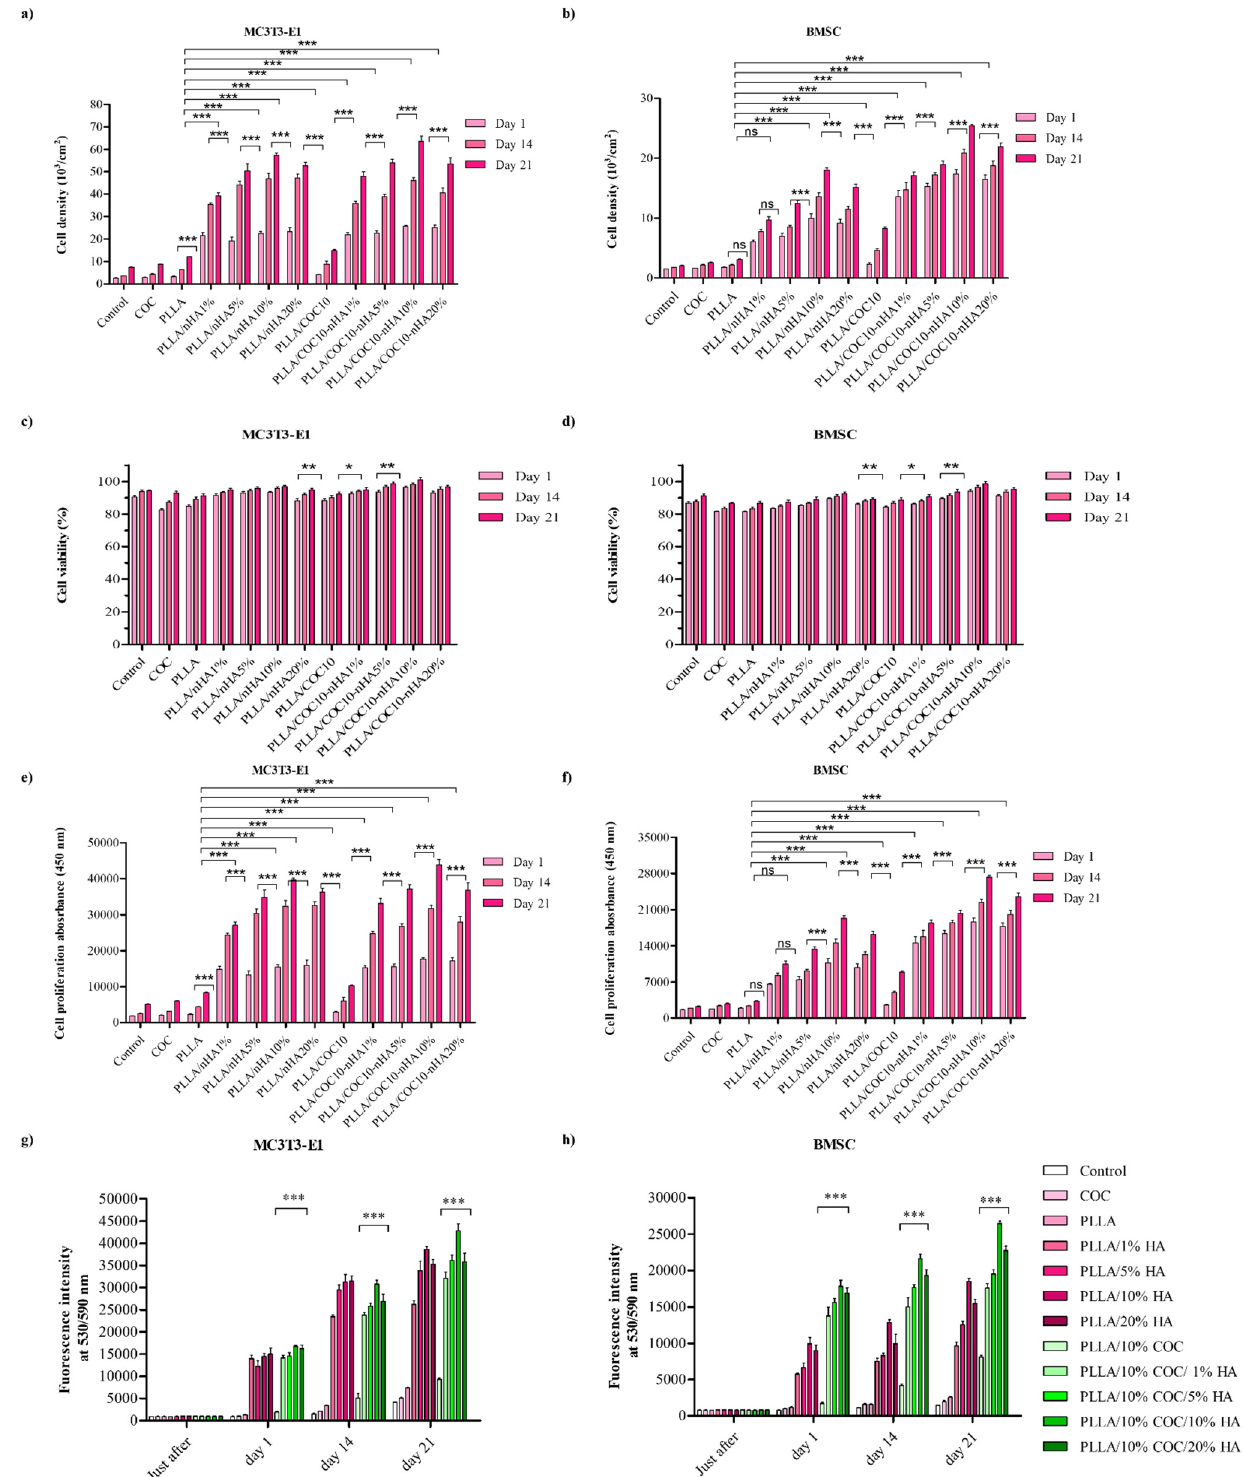
Figure 7. Cell culture data of PLLA and PLLA/COC10: ( a ) MC3T3-E1 density and ( b ) BMSC density. ( c ) MC3T3-E1 viability and ( d ) BMSC viability. ( e ) MC3T3-E1 proliferation rate (OD) and ( f ) BMSC proliferation rate (OD). ( g ) MC3T3-E1 fluorescence intensity and ( h ) BMSC fluorescence intensity. For days 7, 14, and 21, the results were statistically significant. Nanocomposites had nHA in 1 wt%, 5 wt%, 10 wt%, and 20 wt%. (Error bars: ±SD, * p < 0.05, ** p < 0.01, and *** p < 0.001).